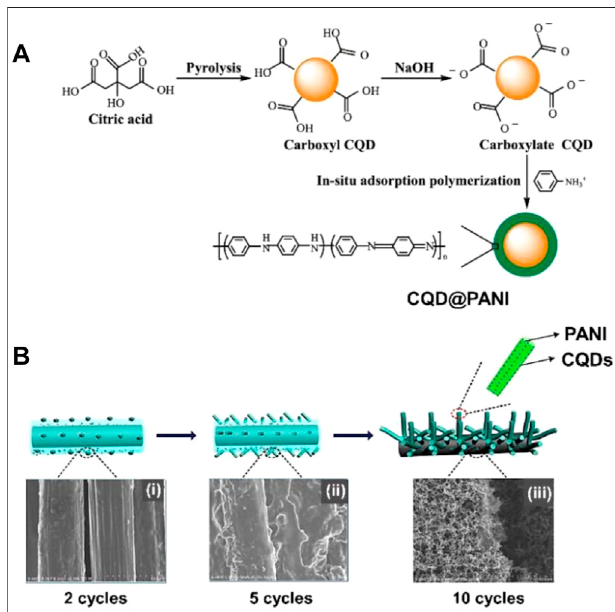
FIGURE 18 | (A) Schematic illustration of the synthesis of core shells C-QDs@PANI by pyrolysis. (B) Schematic illustrations and corresponding SEM images of C-QDs@PANI/CFs (LI). Reprinted with the permission from (Permatasari et al., 2021).